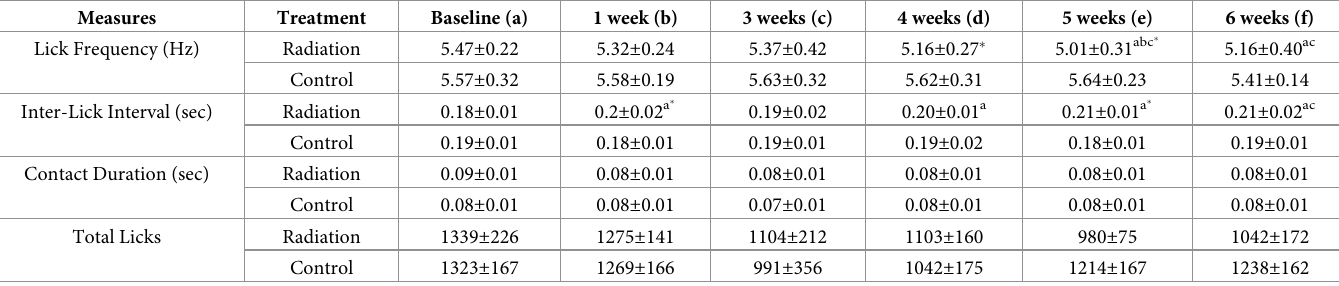
Table 2. Descriptive statistics for each treatment across time.